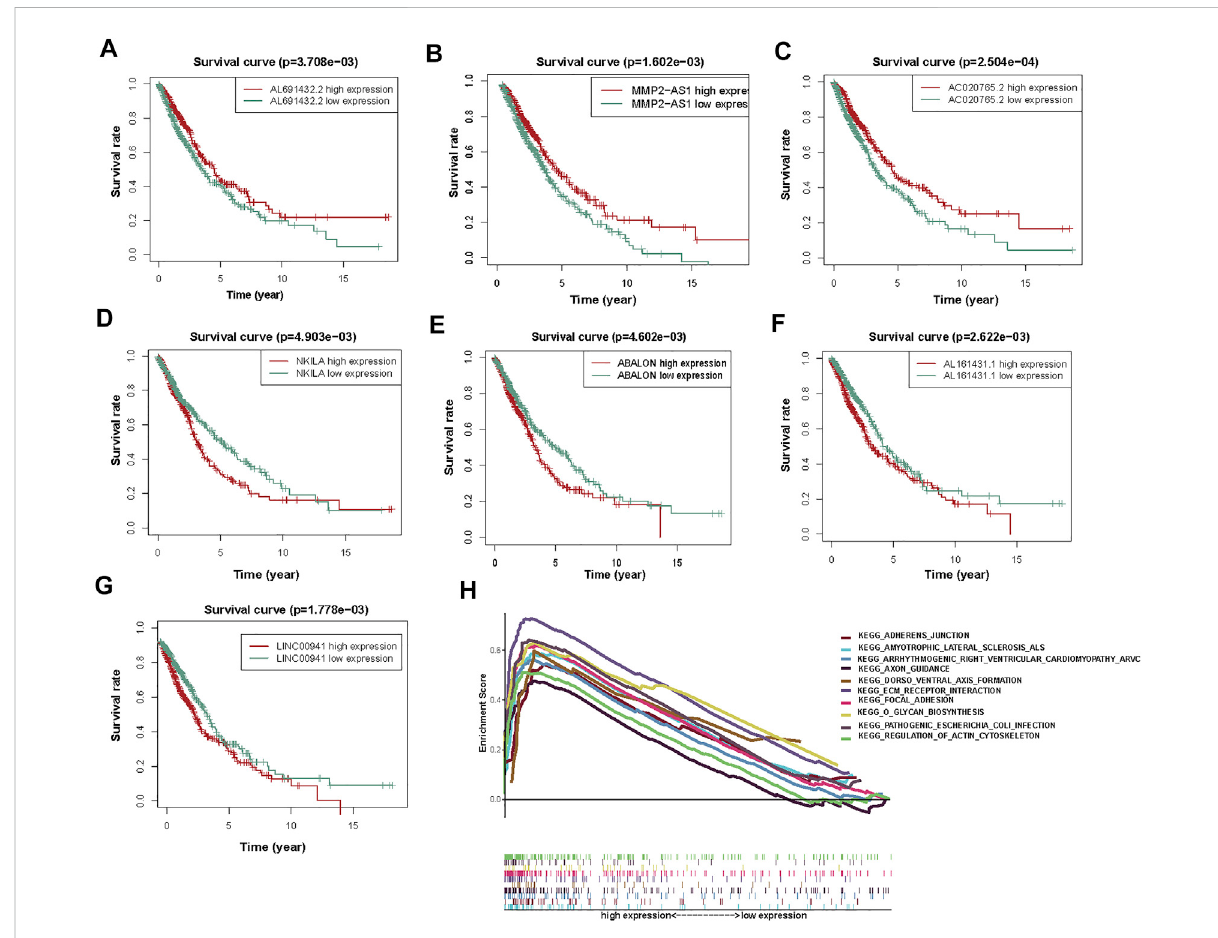
FIGURE 5 The KM survival curves and GSEA analysis of 7 prognostic autophagy-associated lncRNAs. (A) AL691432.2, (B) MMP2-AS1, and (C) AC020765.2 were favorable prognostic factors. (D) NKILA, (E) ABALON, (F) AL161431.1, and (G) LINC00941 were harmful prognostic factors. (H) Top ten primarily enriched categories of 7 autophagy-associated lncRNAs in the high-risk group by